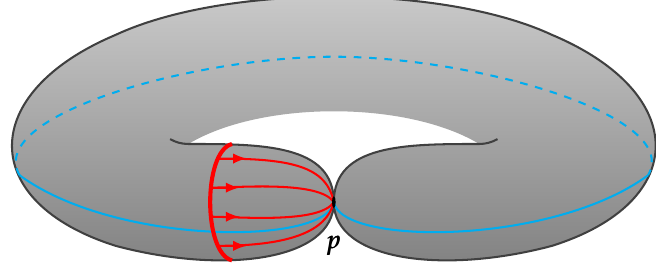
Figure 21. A singular torus